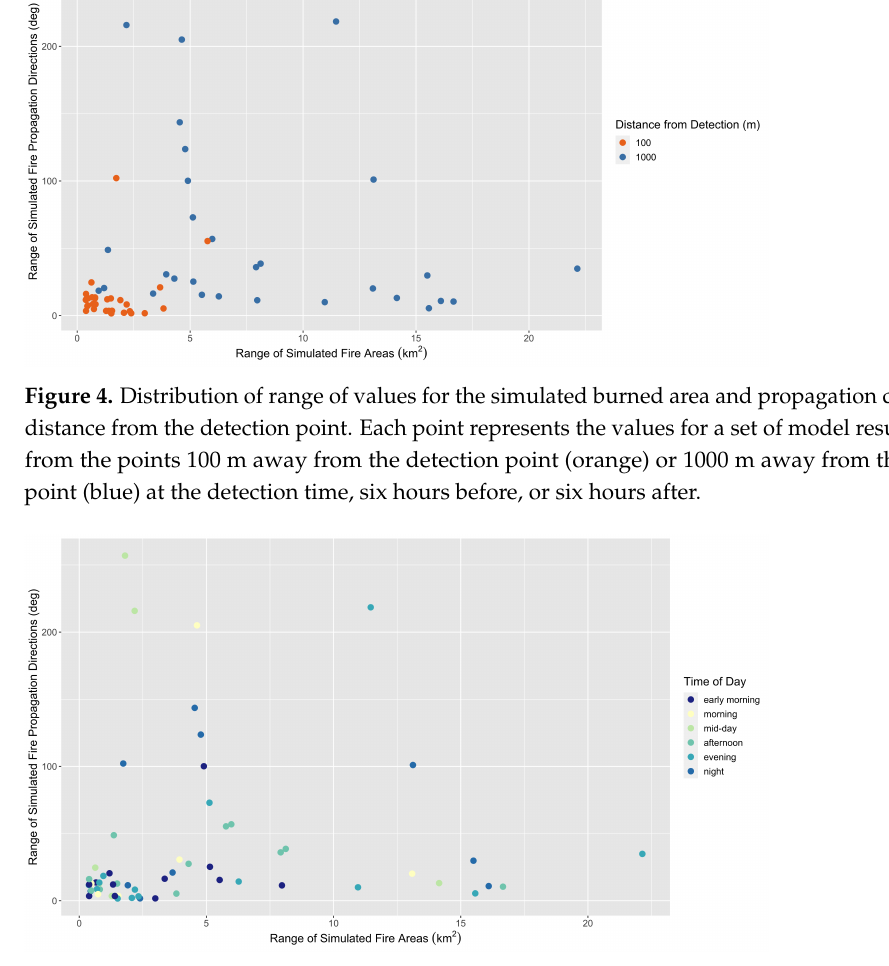
Figure 5. Distribution of the range of values for the simulated burned area and propagation directions by time of day. Each Time class represents four hours; “early”: 2:00 a.m.–5:59